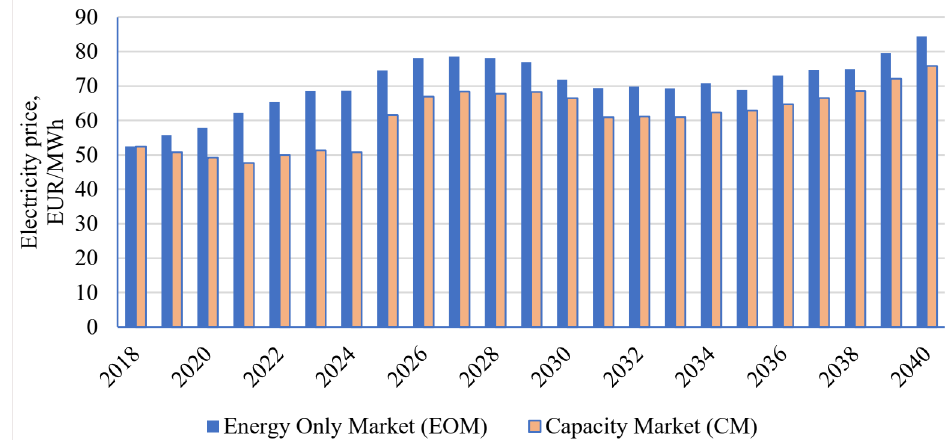
Figure 19. Electricity prices under the EOM and CM scenarios in